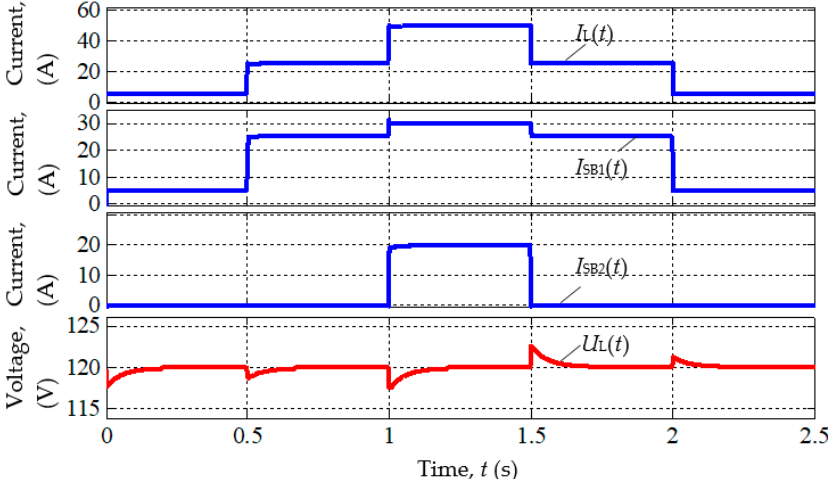
Figure 17. Transient processes in the system with abrupt changes in the load current I L = 5–25–50–25–5 А . I SB1 , I SB2 —currents supplied to the load by solar panels No. 1 and No. 2; U L —load voltage.